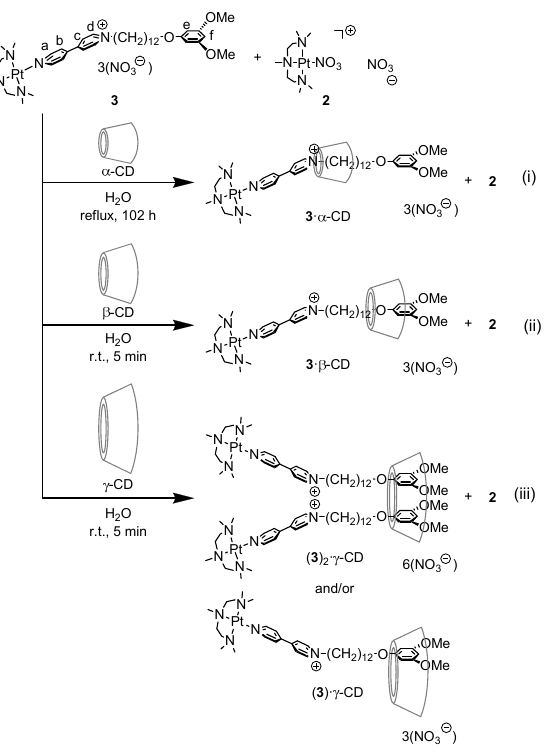
Scheme 2. Preparation of cyclodextrin rotaxanes. Symbols a-f in complex 3 denote aromatic hydrogens at the respective positions. They correspond to the NMR spectra in Figures 1(K) and 2(N). (i)–(iii) show the rotaxane or pseudorotaxane obtained from α -, β -, and γ -cyclodextrins, respectively. Molecules 2020 , 25 , x